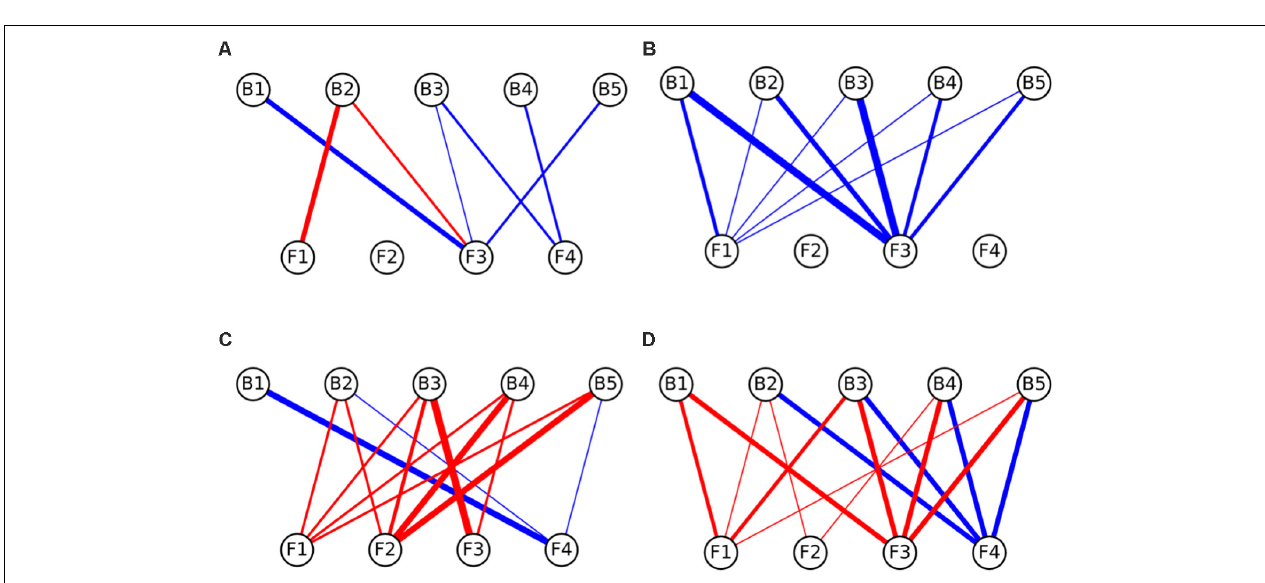
FIGURE 4 | Interaction networks indicating the effects of bacteria on fungal colony growth on (A) CP medium, (B) MM medium, (C) PDA medium, and (D) LB medium. Circles on the top row represent bacterial strains, while circles on the bottom represent fungal isolates. Blue lines represent interactions where bacteria enhanced the growth of fungi (induction), while red lines represent interactions where bacteria inhibited the growth of fungi (repression). The width of the line denotes the strength of the observed interactions (see section “Materials and Methods”). Strains abbreviations are as follows: F1: Coprinellus micaceus 1; F2: Cladosporium sp.; F3: Coprinellus micaceus 2; F4: Aspergillus niger ; B1: Aeromonas sp. 1; B2: Vibrio sp.; B3: Aeromonas sp. 2; B4: Aeromonas sp. 3; B5: Aeromonas sp.